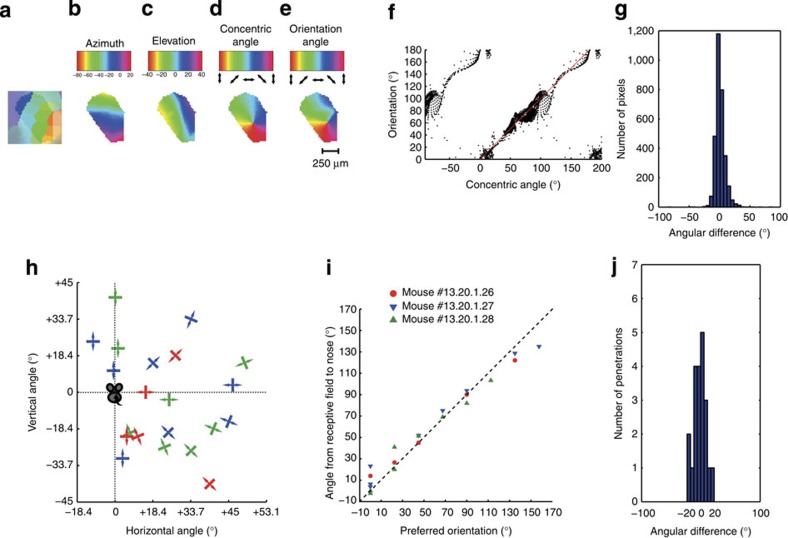
Concentric orientation preferences.(a) Retinotopic map of one example mouse captured by wide-field calcium imaging. The area inside the computed convex hull of the centre responses for all monitor patches is highlighted and used in the following analyses. (b,c) The retinotopic map of a recomputed in azimuth and elevation coordinates, respectively. (d) Map of the concentric angle (that is, the angle orthogonal to the radial angle for the centre of vision) reconstructed based on b and c. (e) The corresponding imaged orientation map. (f) Preferred orientation of the pixels of orientation maps versus the concentric angles computed from the retinotopy for all mice (n=7). (g) Histogram of angular difference between preferred orientation and computed concentric angles of the pixels (7 mice). (h) Preferred orientation of penetrations (n=21, 3 mice), obtained by extracellular recordings, shown at the corresponding receptive field positions. Different colours indicate different mice. (i) Concentric angles at receptive fields relative to the nose versus the corresponding preferred orientations based on the data shown in h. Different colours indicate different mice. (j) Histogram of angular difference between preferred orientation and concentric angles of units shown in h and i.